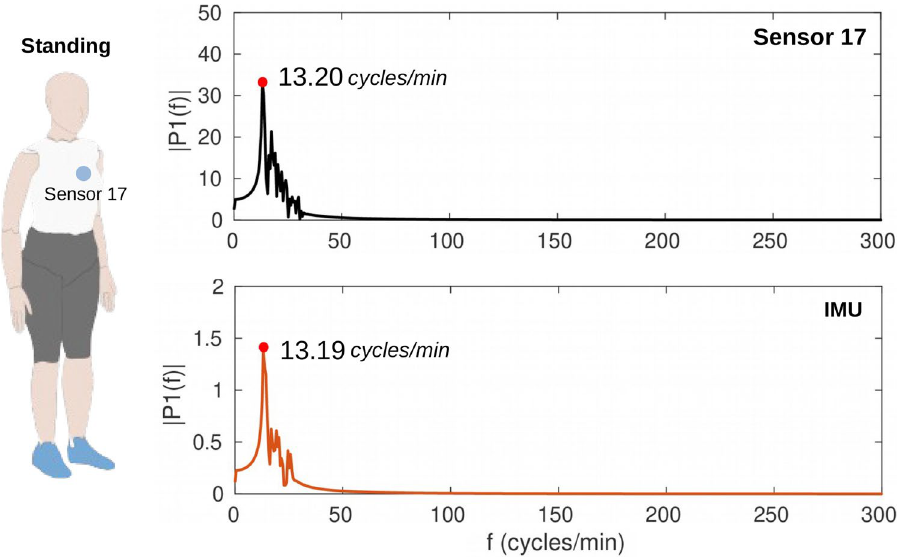
Figure 9. FFT of the IMU data (pitch) and the response of sensor 17 during standing activity of the volunteer 1 for breathing rate estimation.